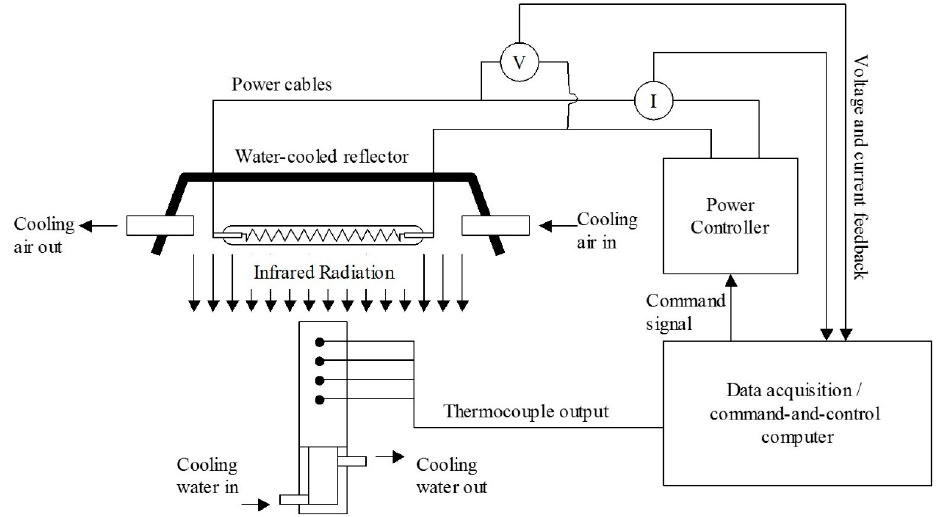
Figure 2. Schematic illustration of the infrared emitter.